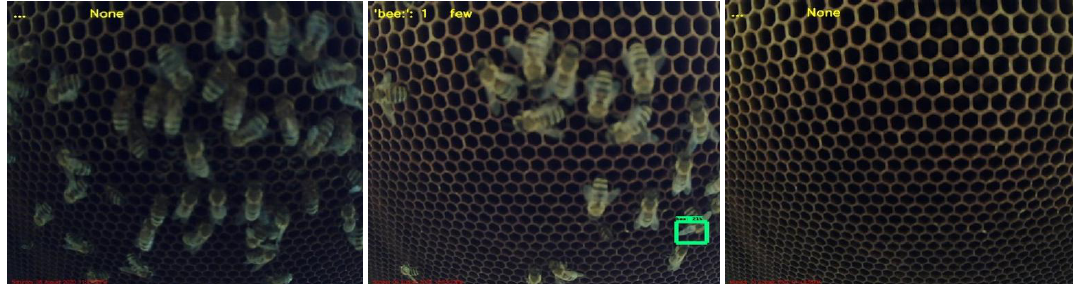
Figure A2. Bee detection with the NVIDIA Jetson Nano using the SSD algorithm, Inception v2 model, for Classes 0, 2, and 3.